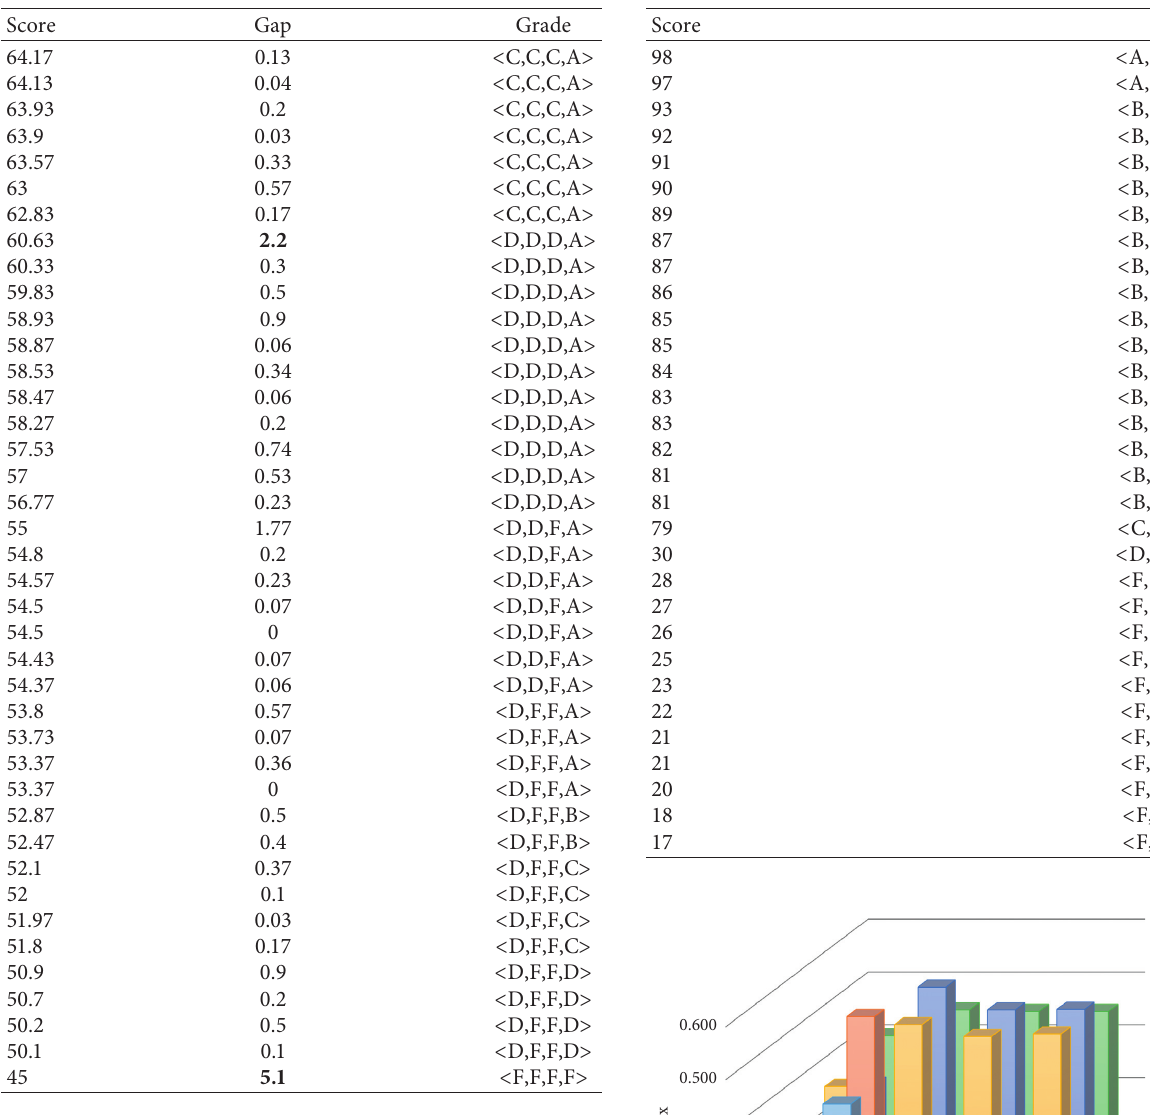
Table 12: Grading results of WD.